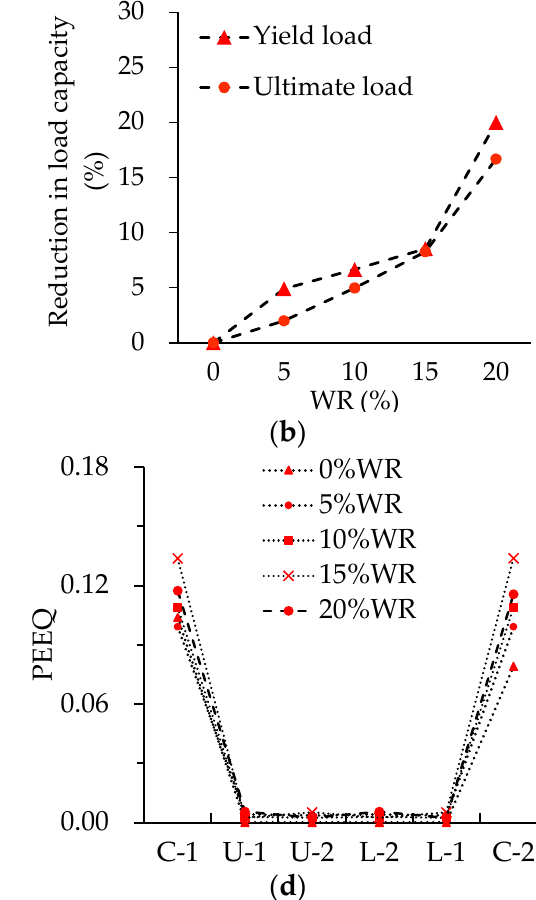
Figure 21. Comparisons of different weight of the corner fitting: ( a ) 6 TC and original models; ( b ) reduction in load-bearing capacity; ( c ) Von Mises distribution of original 6 TC model; and ( d ) PEEQ distribution of original 6 TC model.